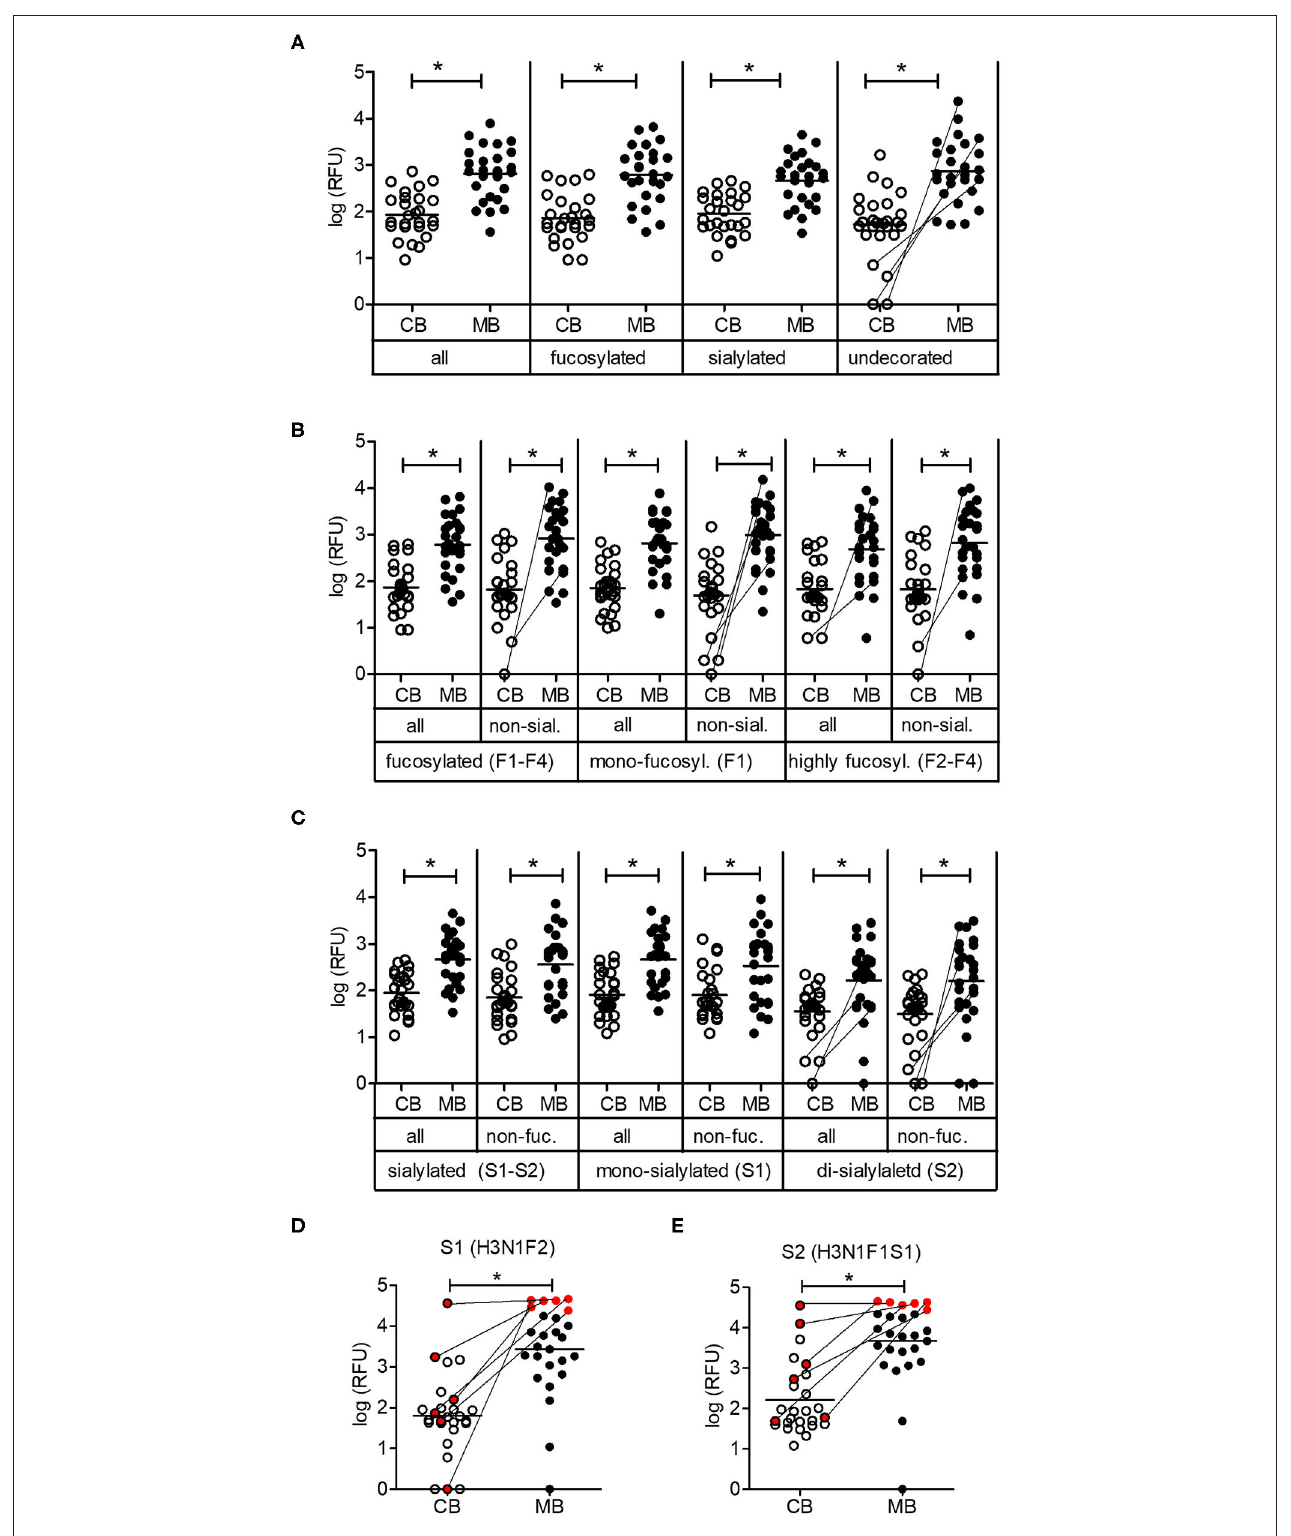
FIGURE 3 | Low maternal transfer of carbohydrate-specific IgG. (A) Mean IgG reactivities to subgroups of glycans on the array shown as log (RFU) for cord blood (CB) and maternal blood (MB) samples. (B) Analysis of subgroups of fucosylated glycans (mono-fucosylated, F1; di- to tetra-fucosylated, F2–F4) (C) Analysis